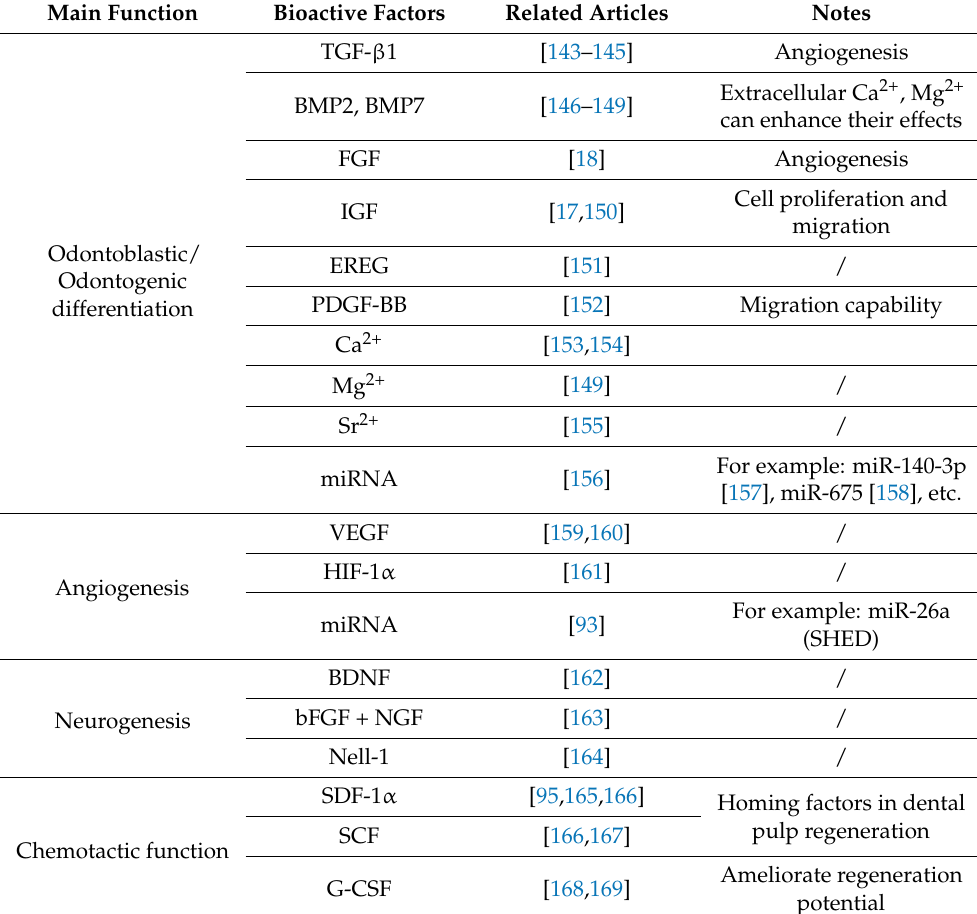
Table 1. Various bioactive factors involved in dental pulp